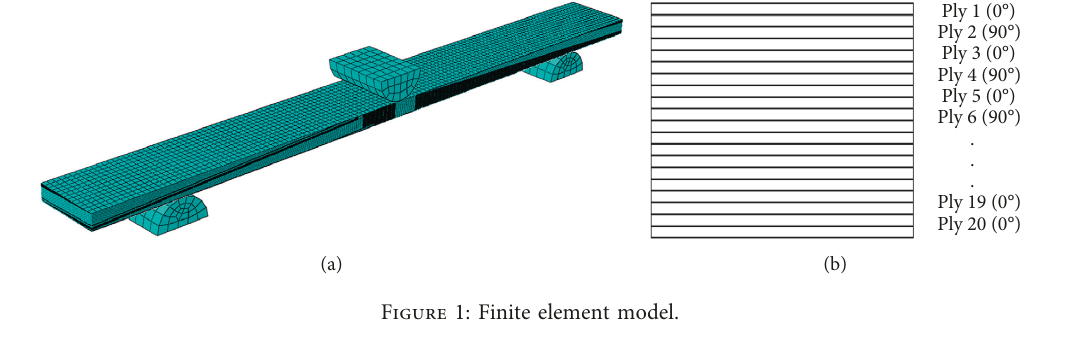
Figure 1: Finite element model.